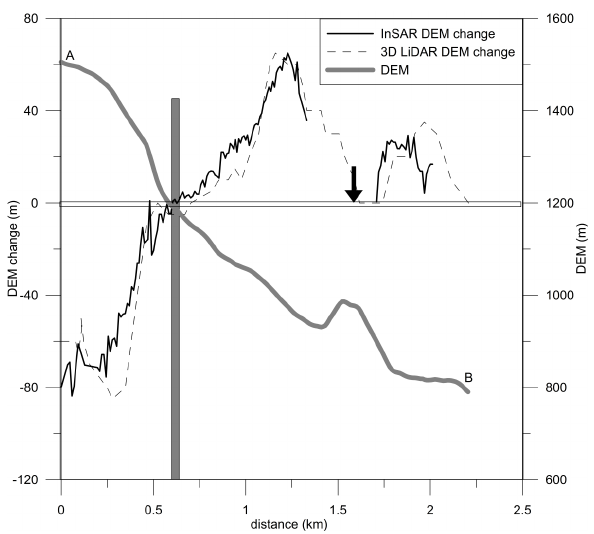
Fig. 10. Cross-section of pre-slide SRTM DEM, DEM change measured by InSAR and 587 Fig. 10. Cross section of pre-slide SRTM DEM, DEM change mea- 3D LiDAR techniques after Jiweishan sliding along profile AB. The vertical grey bar 588 sured by InSAR and 3-D lidar techniques after Jiweishan sliding indicates the transaction point between the source area and the deposit area, while the 589 along profile AB. The vertical grey bar indicates the transaction black arrow shows the location of scouring area between two deposit areas. 590 point between the source area and the deposit area, while the black arrow shows the location of scouring area between two deposit ar-